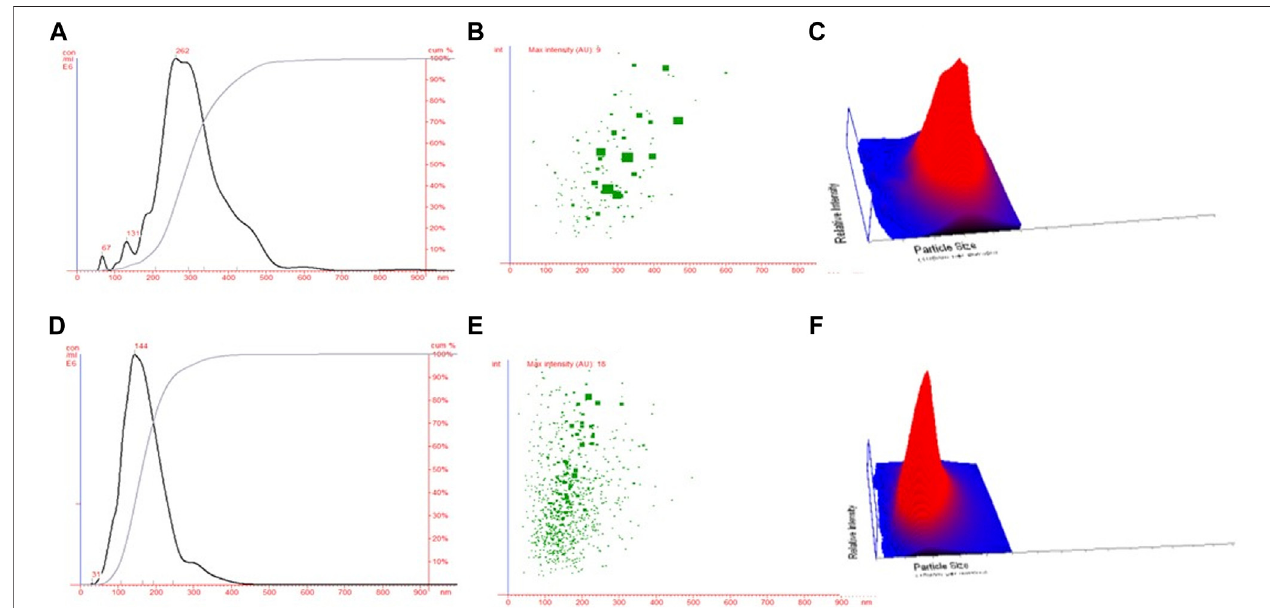
FIGURE 4 | Nanoparticle tracking analysis. (A) Particle size versus concentration plot estimating the average size of CHNPs synthesized from commercial CH. Particle size versus relative intensity of CHNPs synthesized using commercial CH in (B) scattered and (C) 3D plot. (D) Particle size versus concentration plot estimating theaveragesizeofNPssynthesizedfromfungalCHextractedfrom C.echinulata NCIM691.ParticlesizeversusrelativeintensityofFCHNPssynthesizedusingfungalCH in (E) scattered and (F) 3D plot.